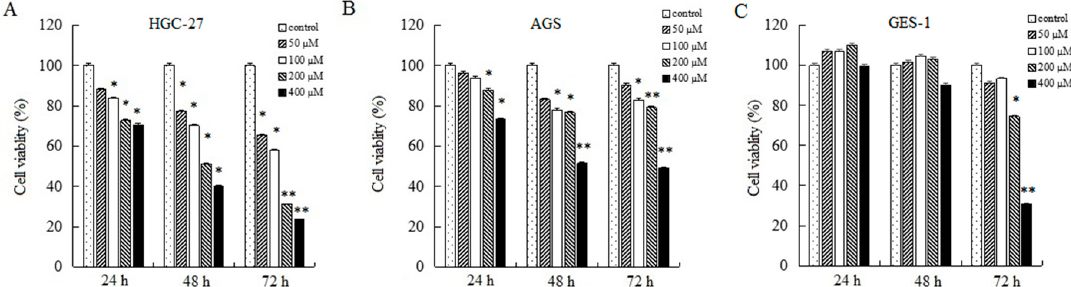
Figure 1. Inhibitory effects of AT-II on cancer cell growth. ( A ) HGC-27, ( B ) AGS and ( C ) GES-1 cells were treated with AT-II at different concentrations for 24 h, 48 h and 72 h. Cell viability was examined by CCK-8 assay. All data were obtained from three independent experiments and expressed as mean ± SD. * p < 0.05 and ** p < 0.01 vs. control group.